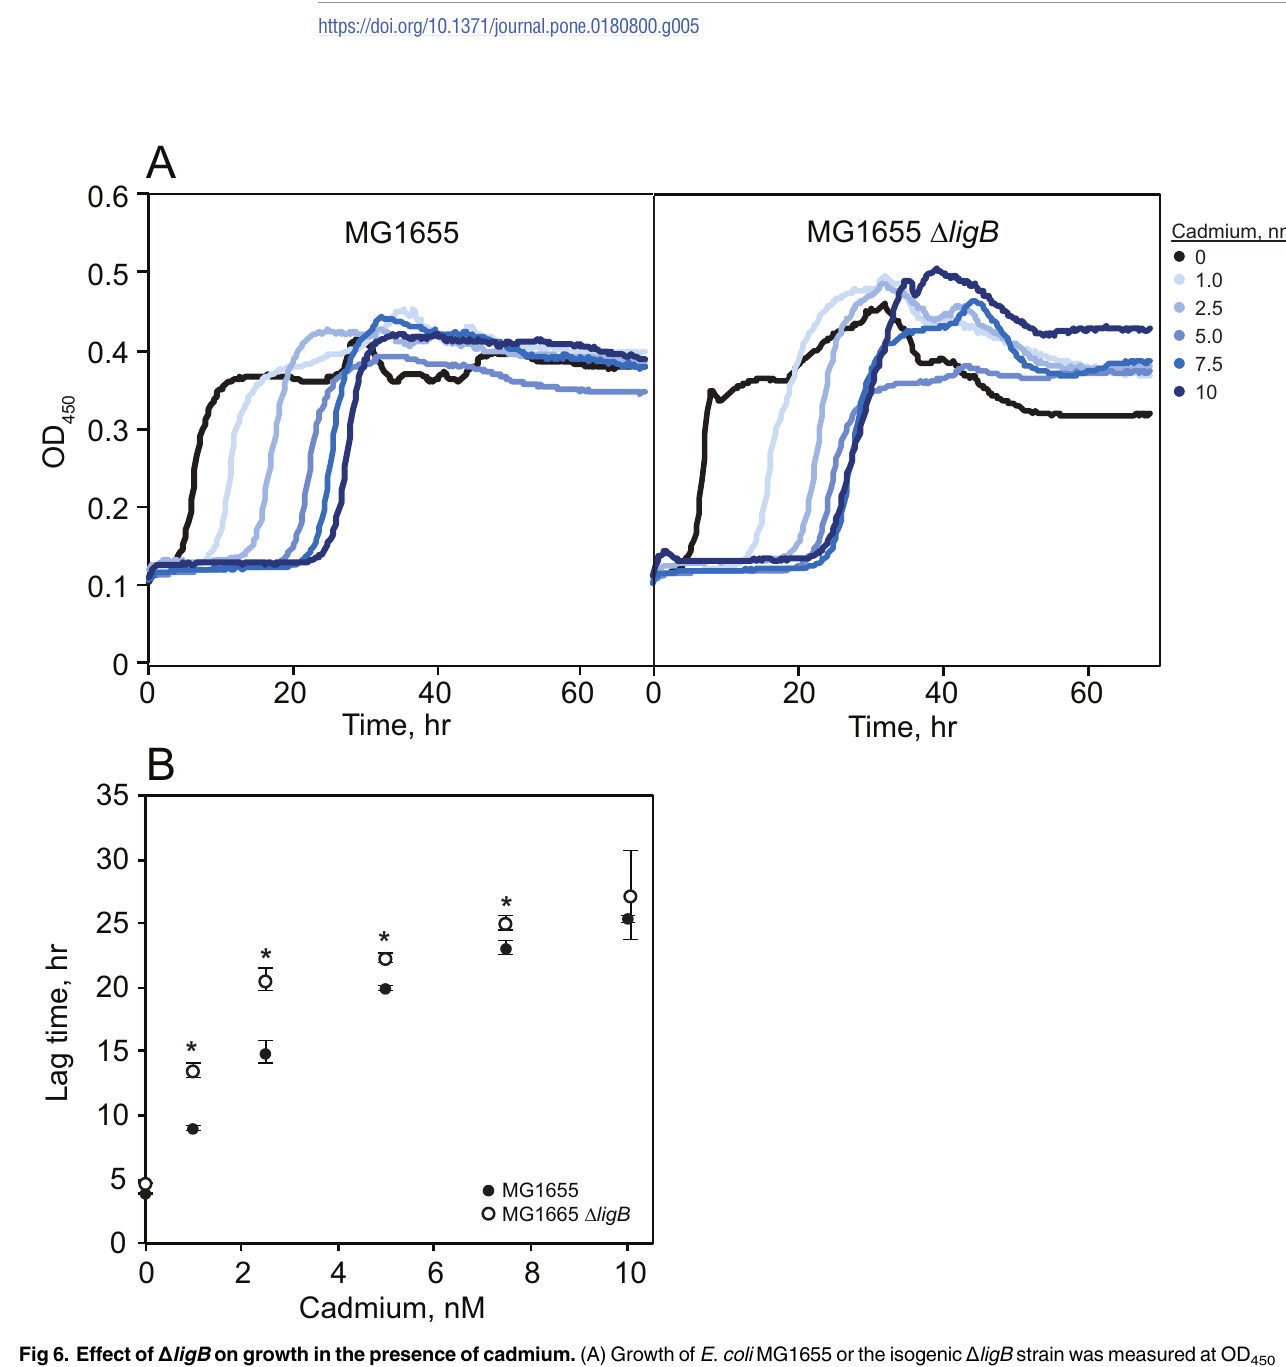
Fig 6. Effect of Δ ligB on growth in the presenceof cadmium. (A) Growth of E . coli MG1655 or the isogenic Δ ligB strain was measuredat OD 450 [19] in the presence of the various indicatedconcentrations of cadmium. Growth without cadmiumis in black and increasingcadmiumis depicted from light blue (lowest) to dark blue (highest). The experiment shown was repeated three additionaltimes (each in triplicate) with similar results. (B) Averagedgrowth lag times of E . coli MG1655 ( ● ) or the isogenic Δ ligB mutant ( (cid:14) ) as a function of cadmiumconcentration. Lag times were calculated with a custom R program [18]. Error bars denote